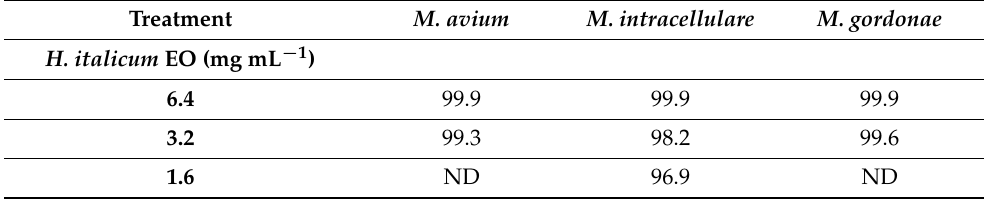
Table 1. Percentage of degradation (%) of mycobacterial biofilms on stainless steel discs after treatment with J. communis EO and/or H. italicum